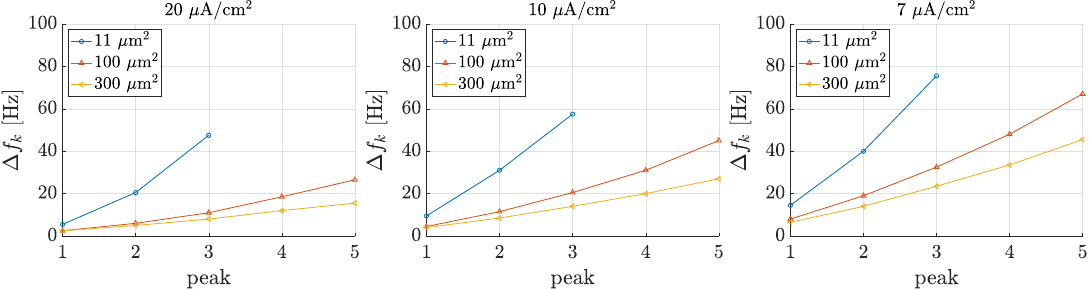
Figure 2. Difference between spectrum peaks of deterministic and stochastic neuron for all currents and